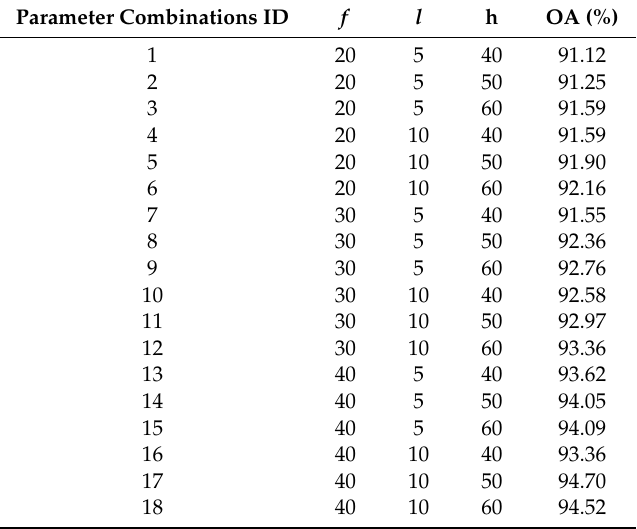
Table 2. Identification results with di ff erent parameter